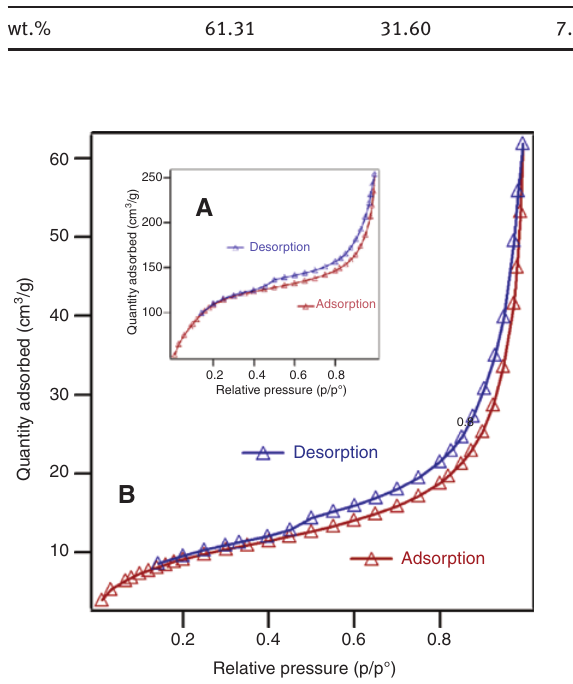
Table 1: Elemental composition of FSM-16-SO Element